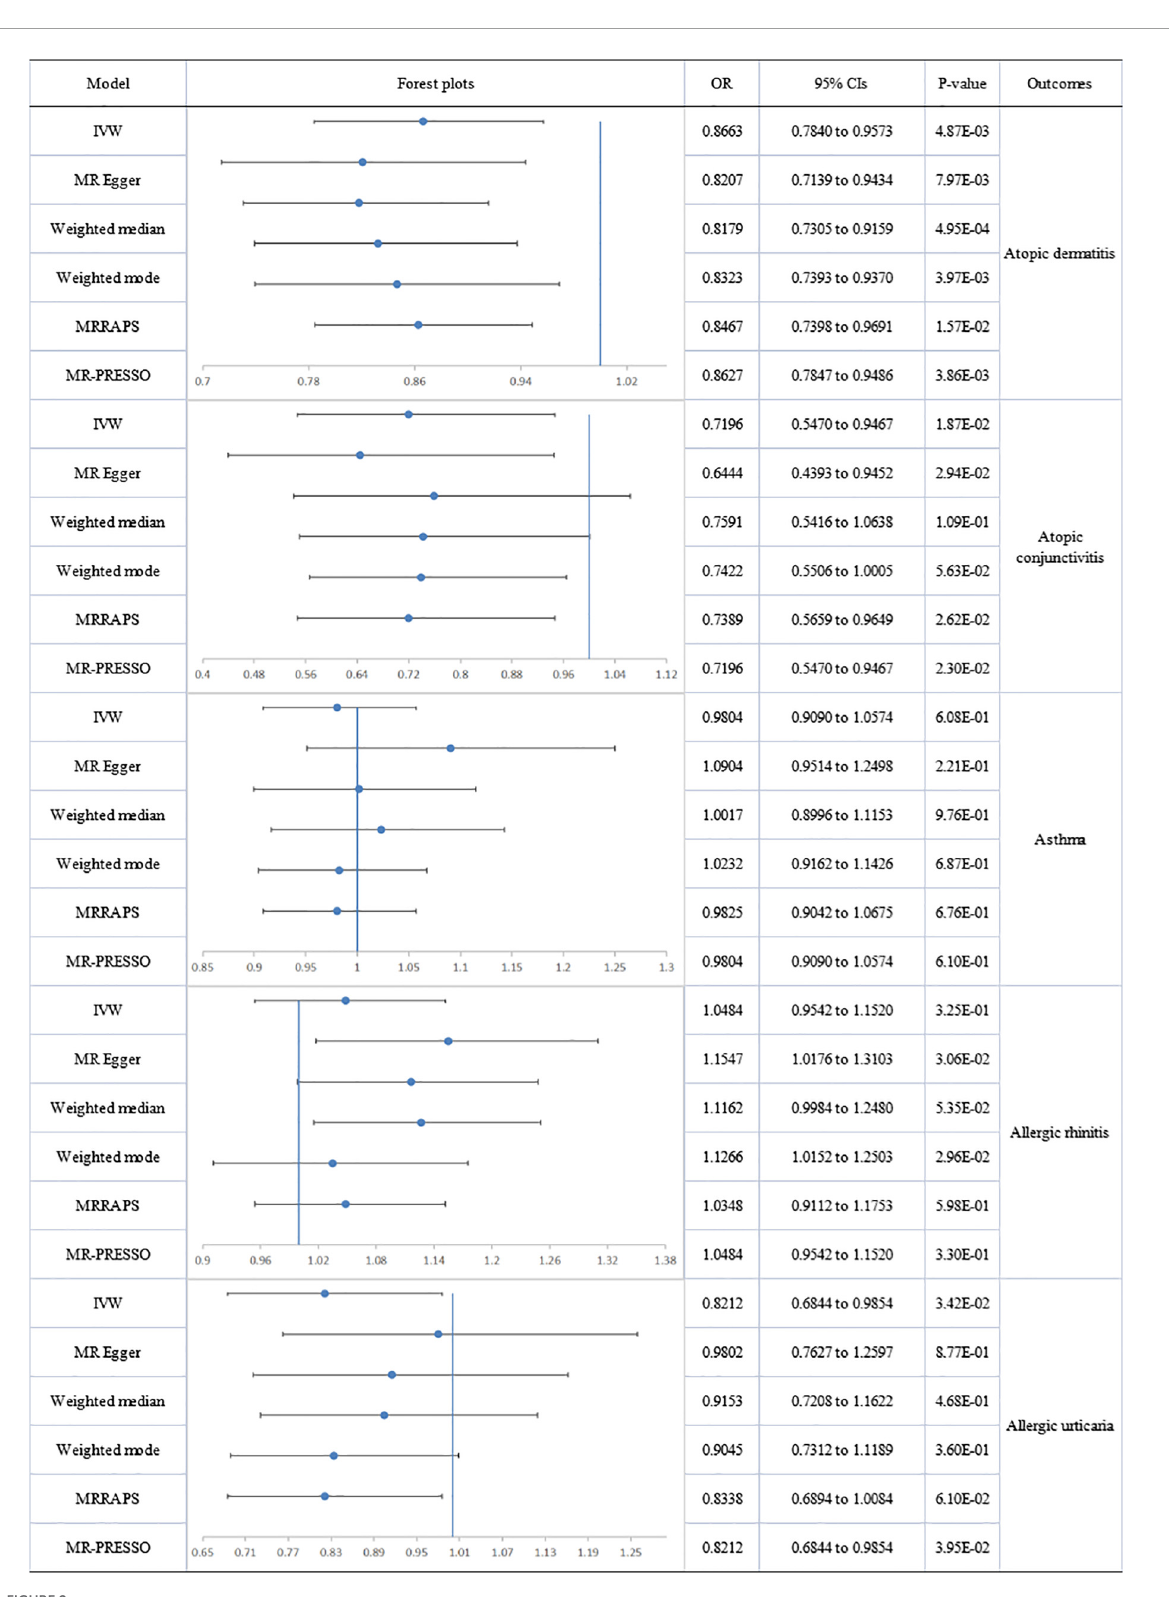
Frontiers in Nutrition